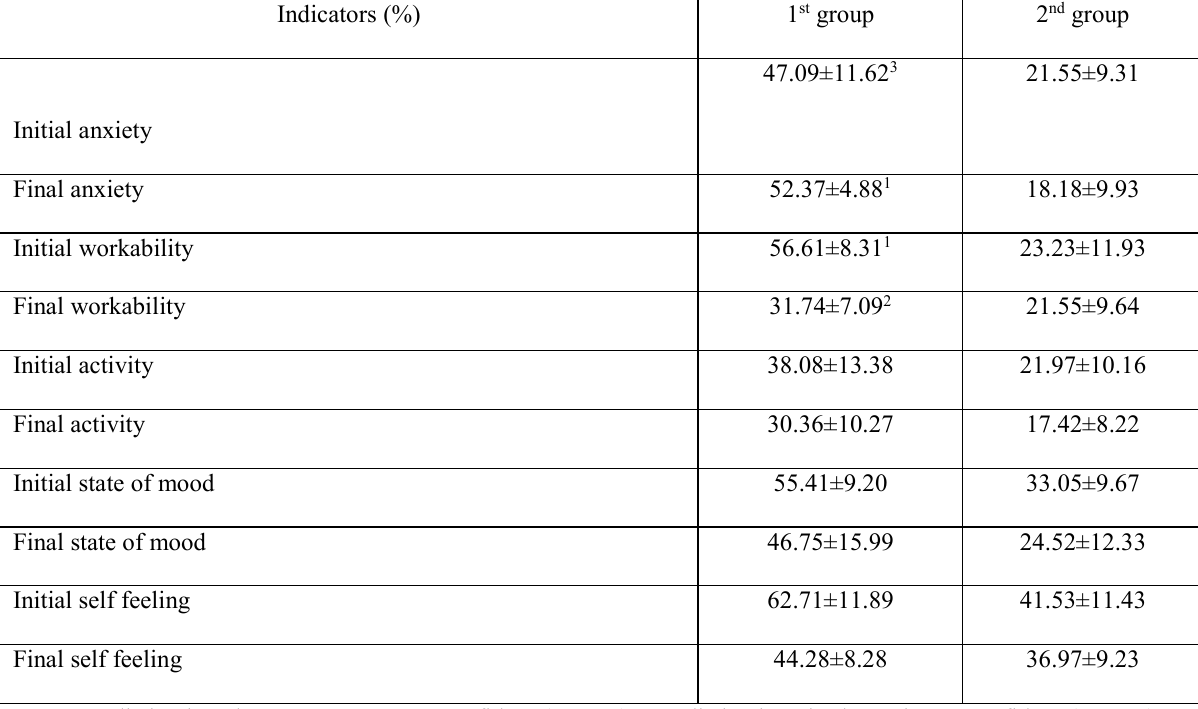
Psychological status of arm wrestlers in dynamic of